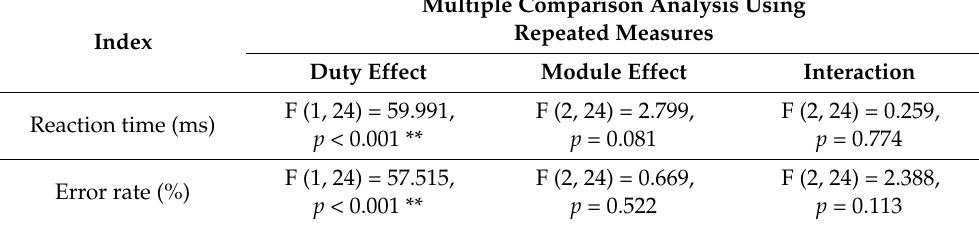
Table 7. The multiple comparison of